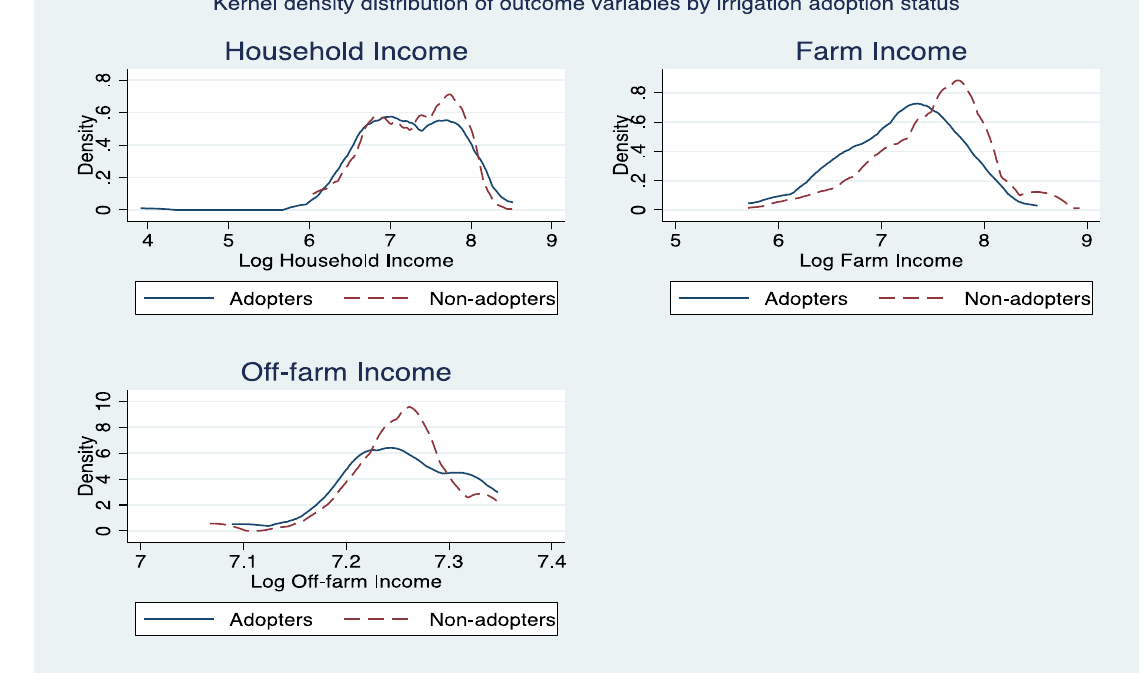
Figure 3. Kernel density distribution of outcome variables by irrigation adoption.